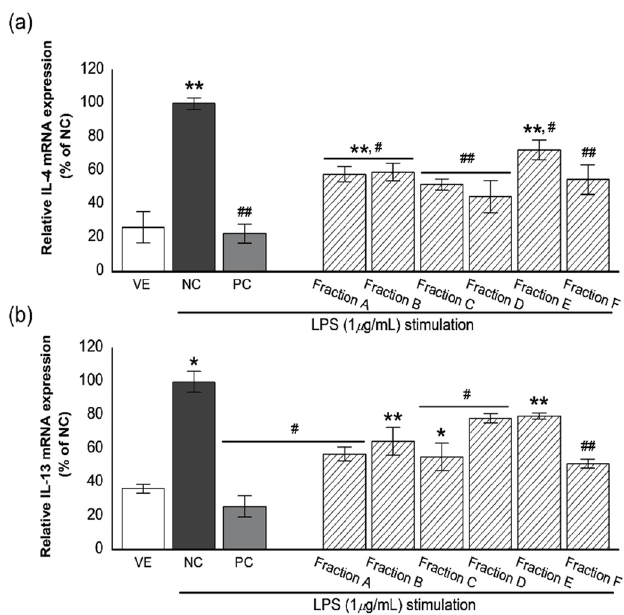
Figure 3. Effect of the six oil fractions on ( a ) IL-4 and ( b ) IL-13 mRNA expression levels in LPS- stimulated RBL-2H3 cells. VE: vehicle, DMSO; NC: negative control, 1- µ g /mL LPS treated group; PC: positive control, 100-nM dexamethasone treated group, an oil fraction (A–F) (10 − 7 %). Values are presented as mean ± standard deviation. * p < 0.05 and ** p < 0.01 compared with VE; # p < 0.05, ## p < 0.01 compared with NC.